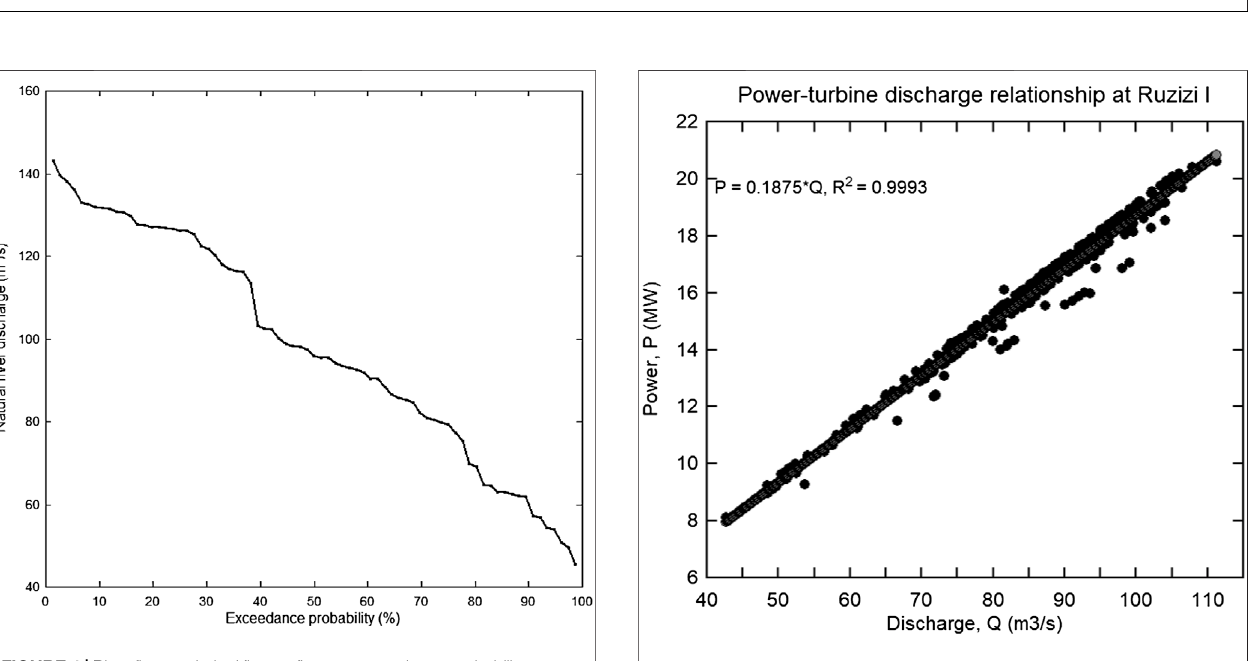
FIGURE5 | Power – turbine discharge relationship at the Ruzizi I HPdam (SNEL, 1989 – 2009). Data sets represent monthly power production and monthly discharge averages of the